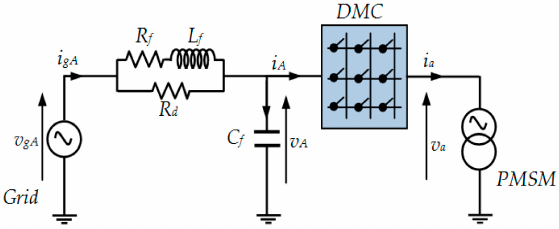
Figure 4. Single phase presentation of passive filter recommended for the DMC.